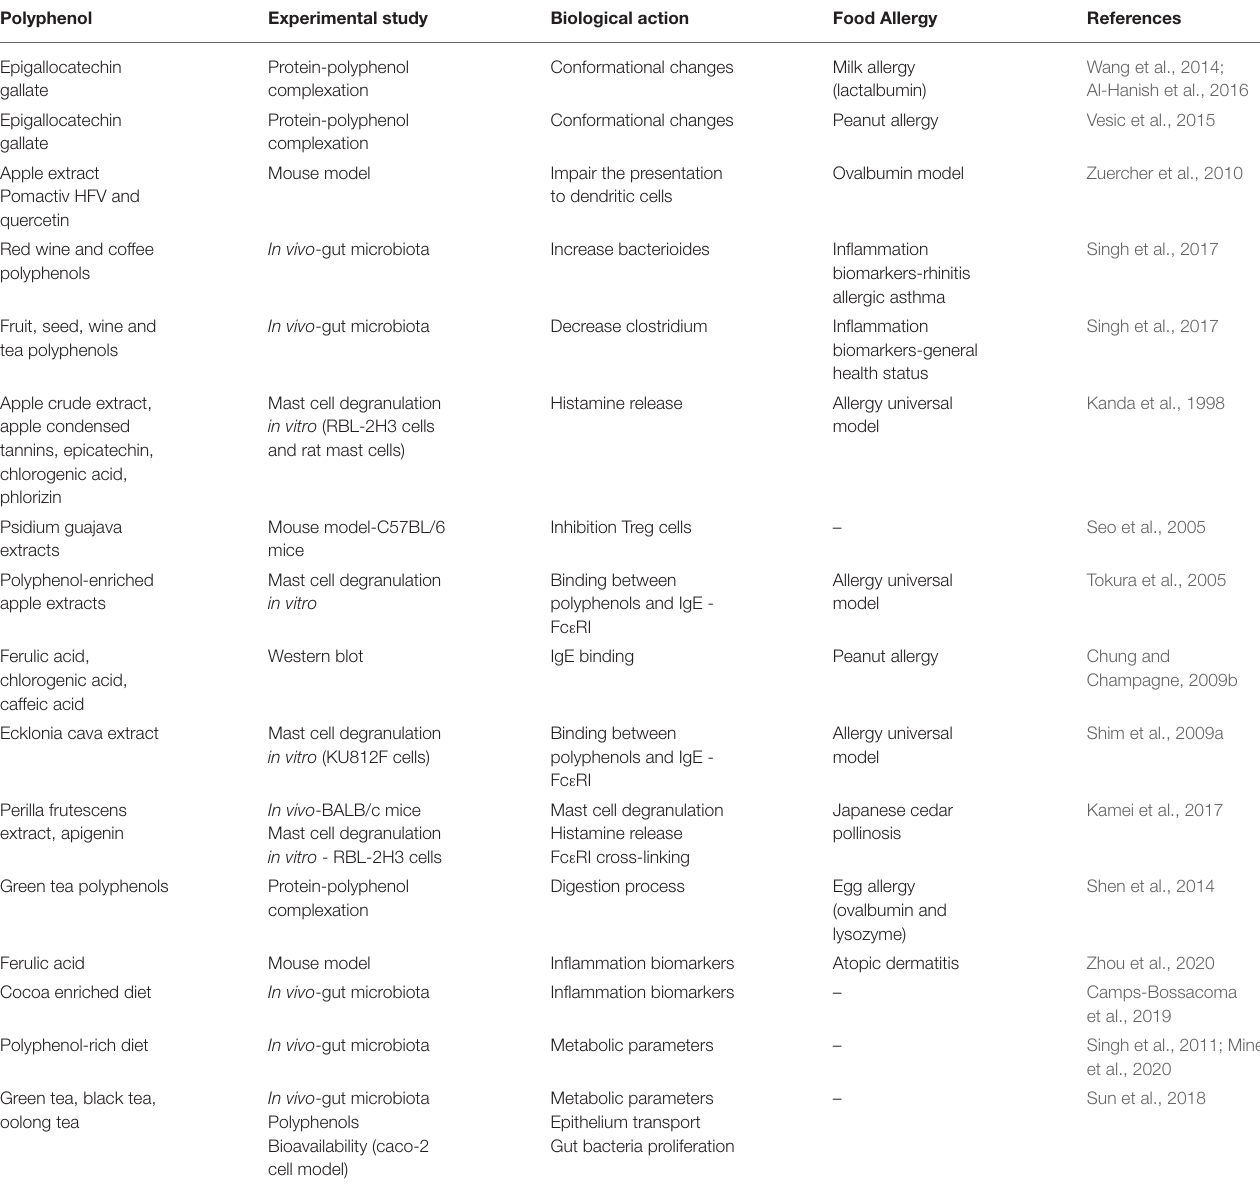
TABLE 2 | Polyphenols assayed and mechanisms probed as modulators of food